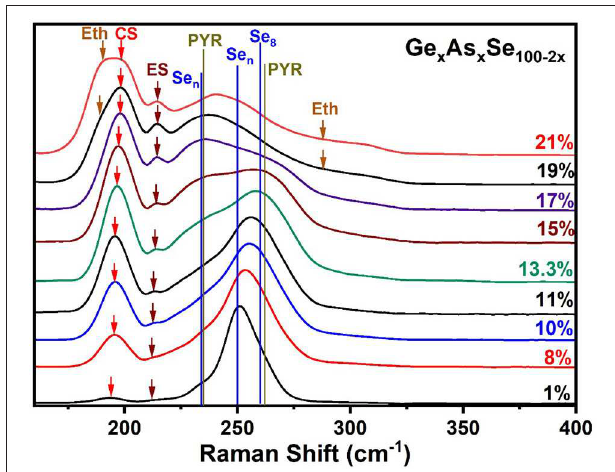
FIGURE 7 | Observed FT-Raman scattering results on Ge x As x Se 100 − 2x ternary glasses as a function of increasing Ge and As content “x.” The expected vibrational modes are labeled. Jackson et al. have calculated these normal modes by NRLMOL code summarized in Table 1 . In the 300 cm − 1 to the 600 cm − 1 range we see weakly excited modes that are presented and analyzed in Figure 8 . The assigned modes are Eth, Ethane; CS, Corner Sharing; ES, Edge Sharing; Se n , Selenium Chain; PYR, Pyramidal; Se 8 , Selenium 8 rings.